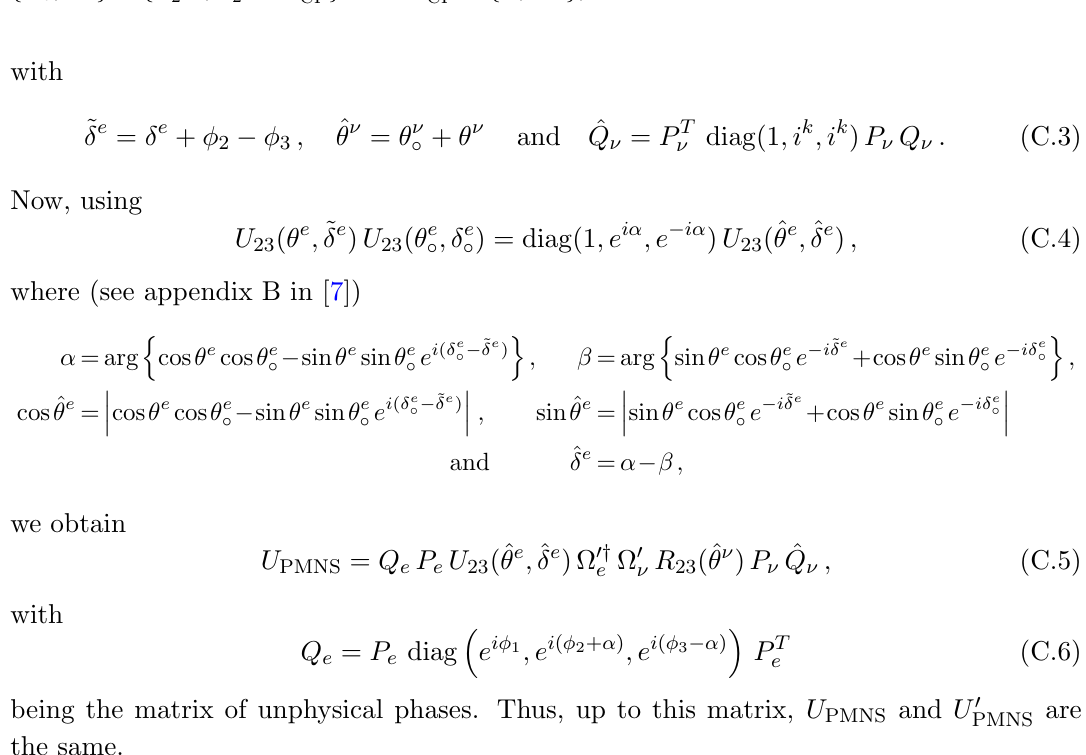
Table 8 . The values of the parameters (cid:30) i , (cid:14) e , (cid:18) e , (cid:18) (cid:23) and k for which eq. (C.1) , proving the (cid:14) (cid:14) (cid:14) equivalence of the PMNS matrix in a given case to the PMNS matrix in the reference case of f G e ; G (cid:23) g = f Z TU ; Z S (cid:2) H (cid:23) g with H (cid:23) = f U; SU g , 2 2 CP CP